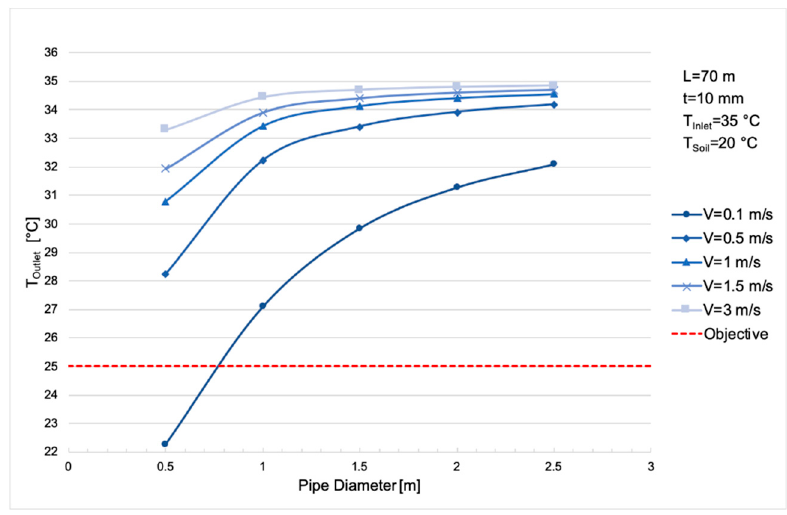
Figure 4. Variation of the outlet air temperature with pipe diameter and air velocity.